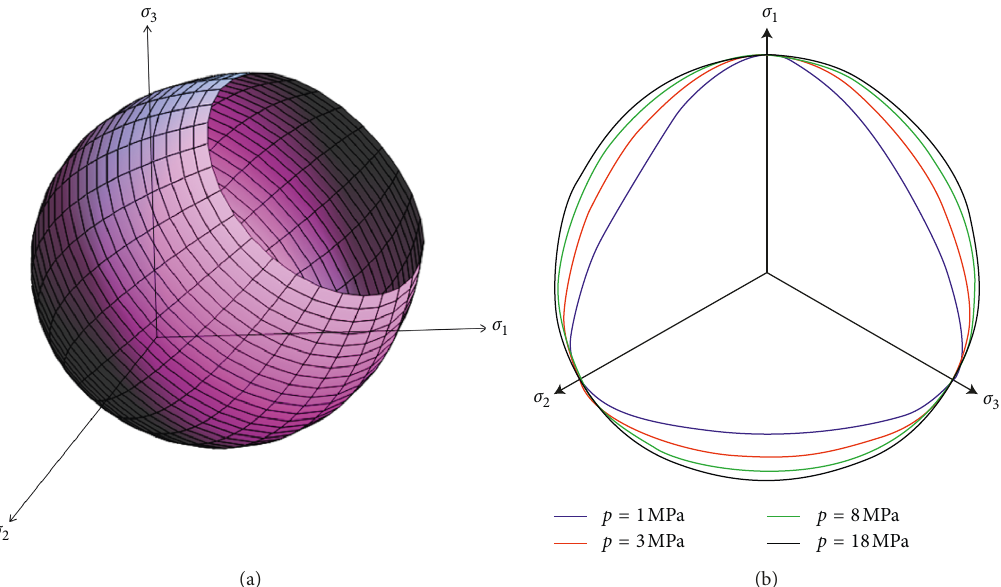
Figure 6: The failure surface and the shape function curves for frozen saline silty clay with salt content 1.5%: (a) principal stress space; (b) π